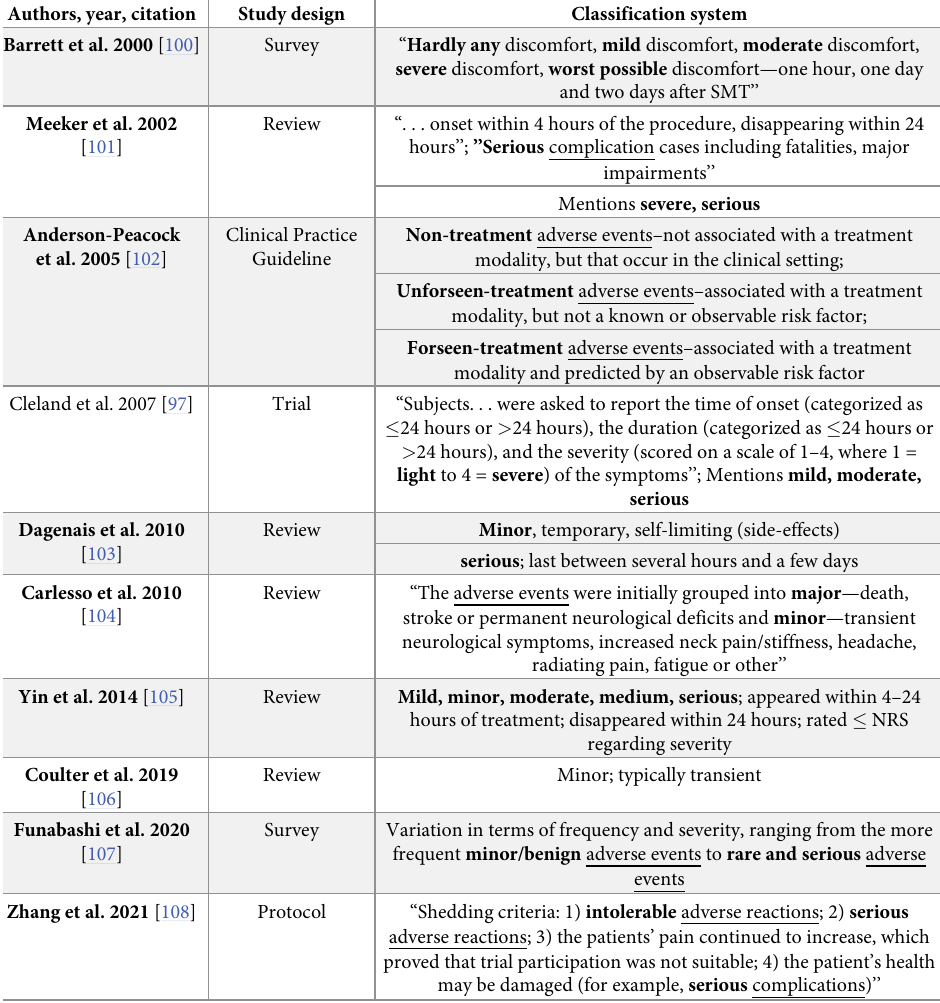
Table 7. Studies providing indirect adverse event classification system only (n =